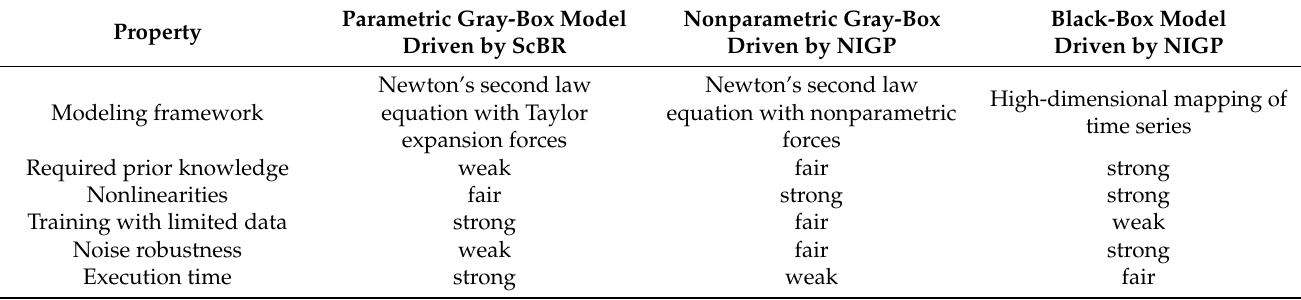
Table 7. Capabilities and challenges of Bayesian gray-box modeling and black-box